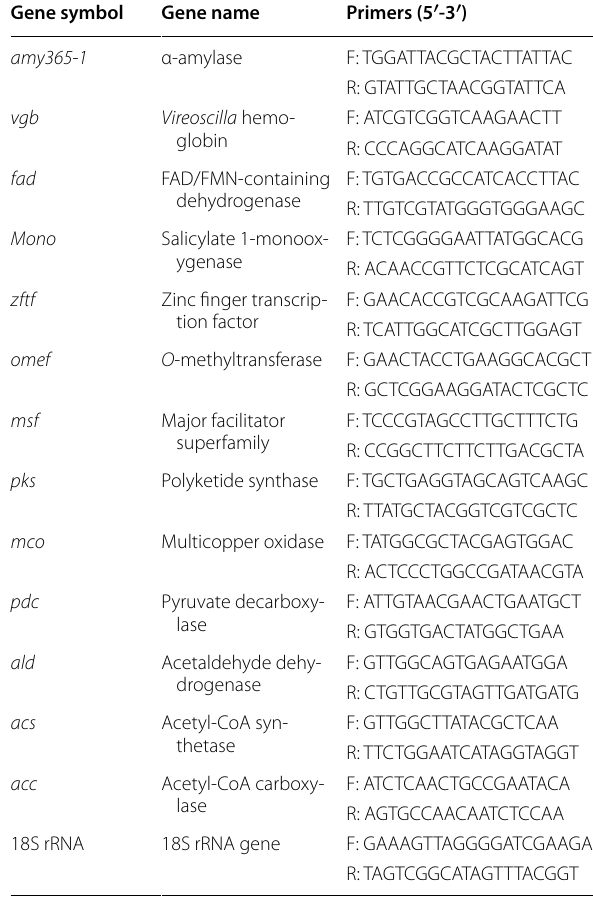
Table 2 Primers and relevant information of reference and target